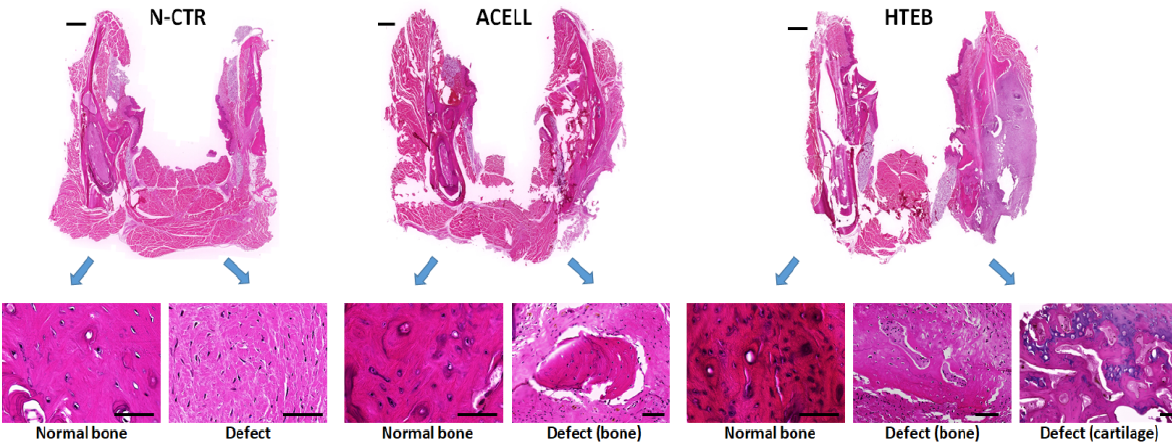
Figure 4. Histological analysis of mandible tissues using hematoxylin and eosin (H&E) staining. Normal bone: tissues corresponding to the non-operated side of the mandible ( left side ); defect: tissues corresponding to the operated side of the mandible ( right side ), showing some areas of bone and cartilage tissue found at this side; N-CTR: animals subjected to surgical removal of a fragment of the right mandible, used as negative controls; ACELL: animals subjected to surgical removal of a fragment of the right mandible and implant of a nanostructured fibrin–agarose biomaterial; HTEB: animals subjected to surgical removal of a fragment of the right mandible and implant of a nanostructured human tissue-engineered bone substitute. Scale bars correspond to 1000 µm in the top images representing low-magnification images and 50 µm in the images below obtained at higher magnifications.